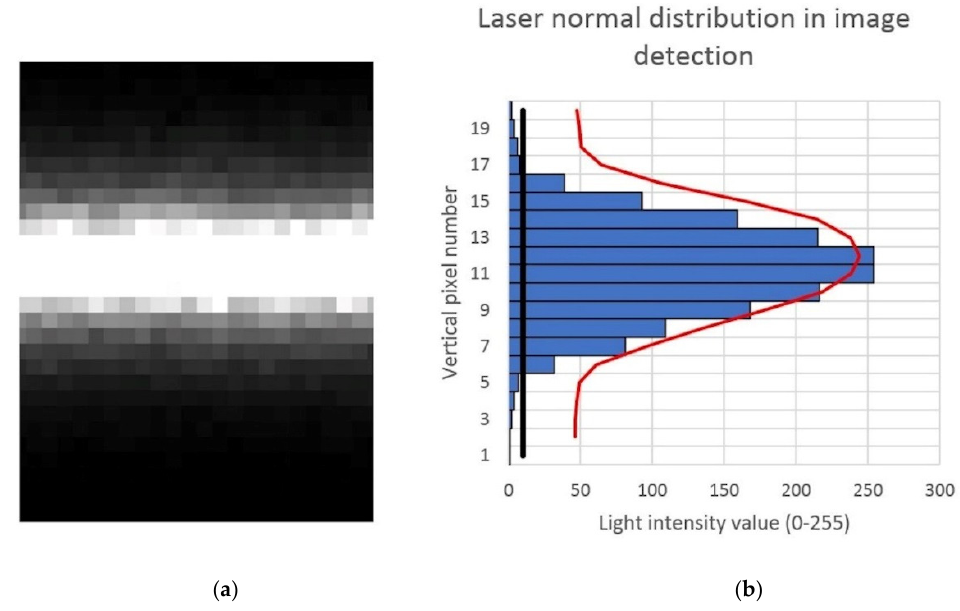
Figure 2 . Laser line detection procedure in image: ( a ) part of the laser line detection for each pixel; ( b ) pertinent histogram for a pixel column with each pixel’s light intensity value.